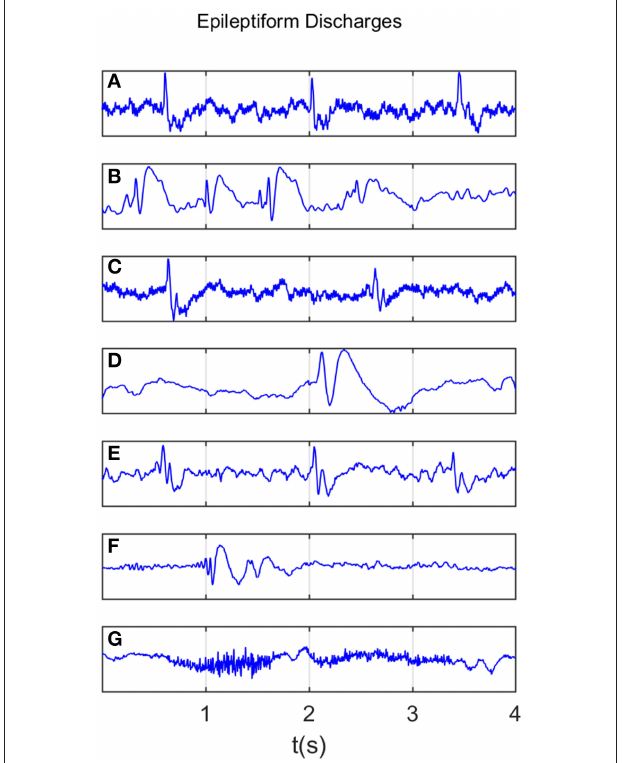
FIGURE 1 | Typical waveforms of the 7 major epileptiform EEG, where (A-G) , denotes spike wave, spike and slow wave complex, sharp wave, sharp and slow wave complex, polyspike complex, polyspike and slow wave complex, spike rhythm discharges,